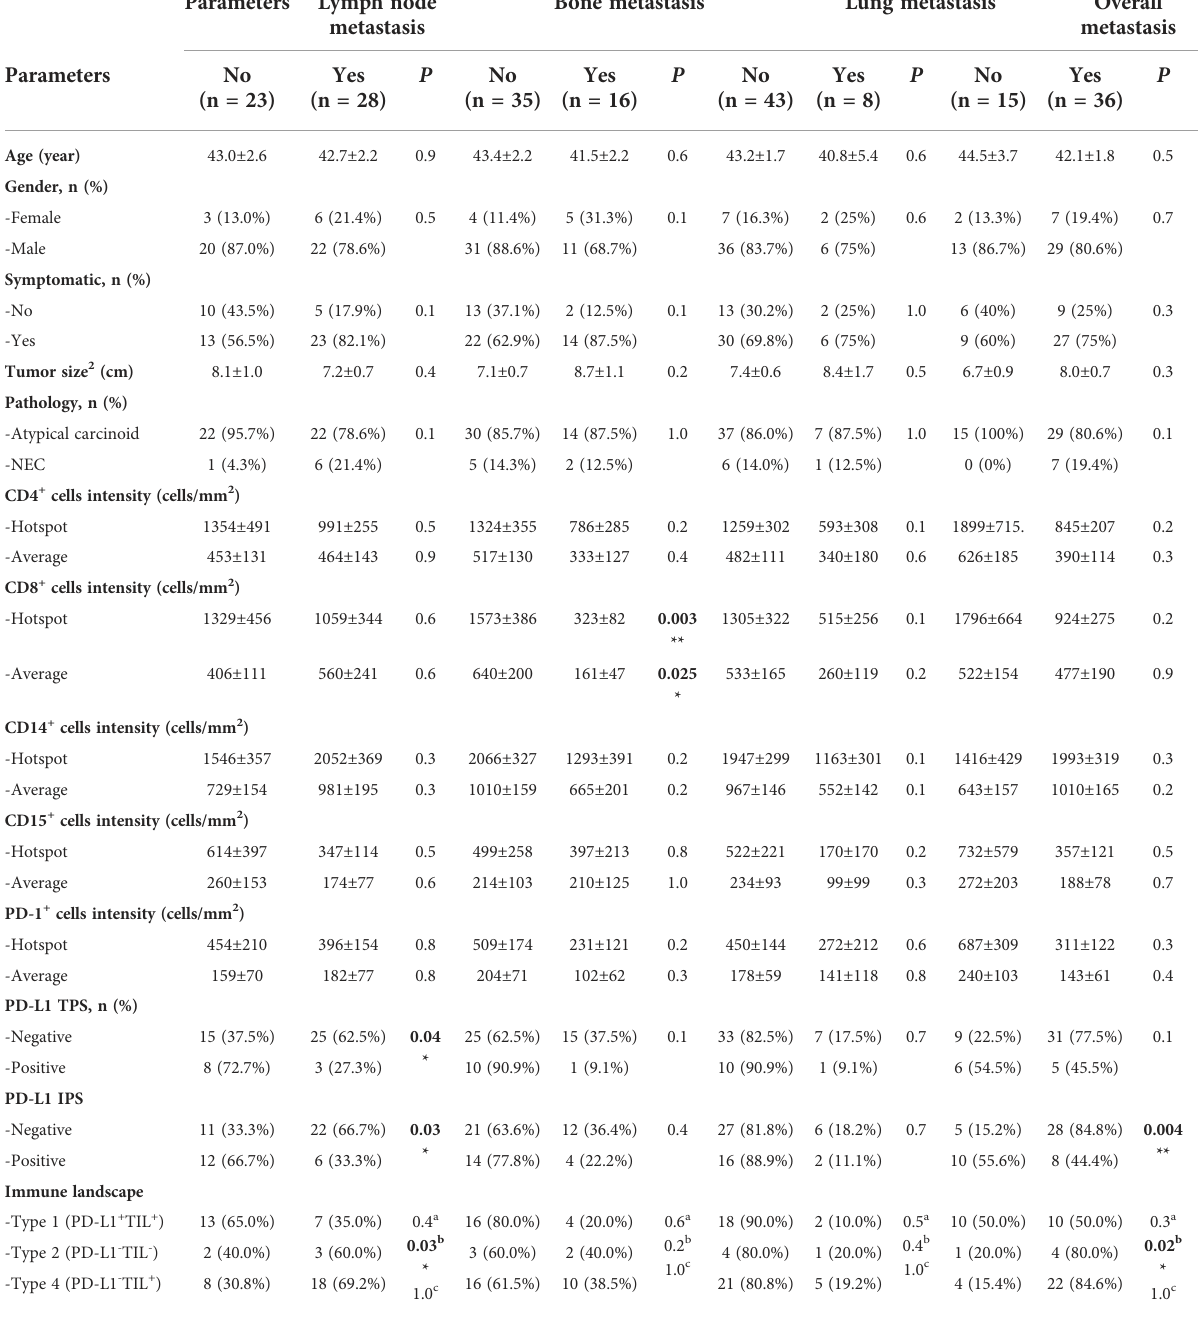
TABLE 4 Patient clinicopathological and immunological characteristics and their correlations with metastasized disease. Parameters Lymph node Bone metastasis Lung metastasis Overall metastasis